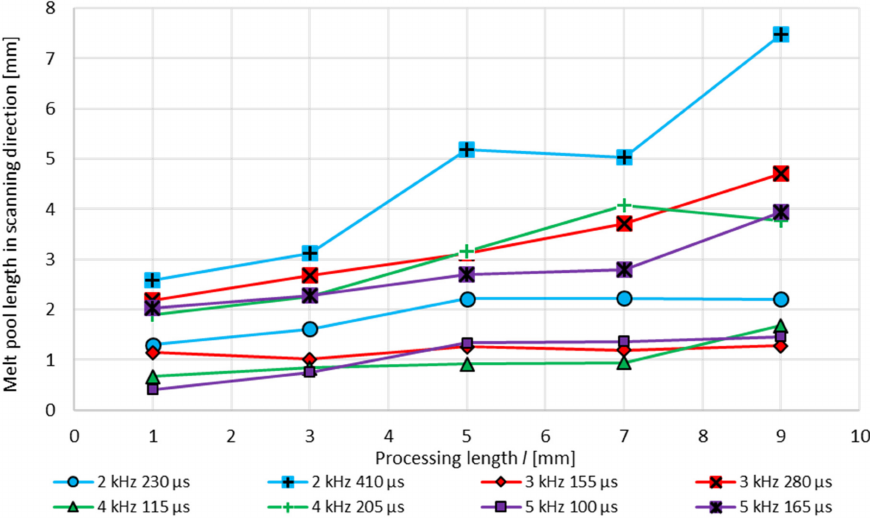
Figure 29. Melt pool length in scanning direction over the processing length l depending on the modulation frequency f m and the modulation time t m .